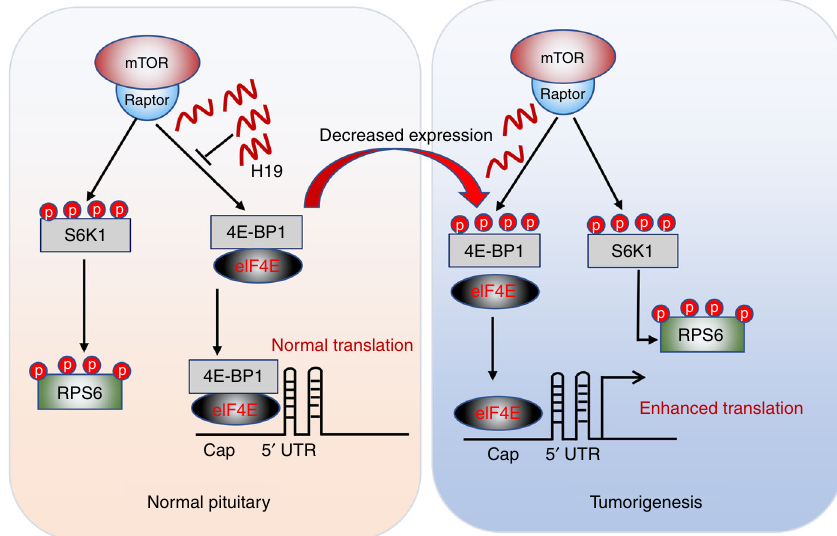
Fig. 8 A model for H19-mediated regulation of 4E-BP1 phosphorylation. When H19 is abundant (right panel), mTORC1 activity is attenuated because H19 inhibits 4E-BP1 phosphorylation by disrupting the interaction between 4E-BP1 and Raptor. The reduced 4E-BP1 phosphorylation allows 4E-BP1 to bind elF4E, thus inhibiting its protein translation function. When H19 is absent, 4E-BP1 binds to Raptor and thus is more readily and effectively phosphorylated. This prevents its interaction with elF4E, resulting in increased protein